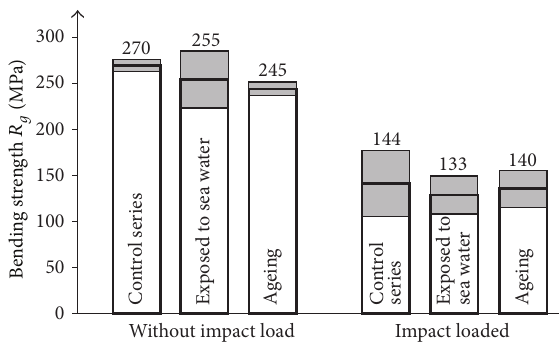
Figure 10: Comparison of flexural strength in composites with hybrid